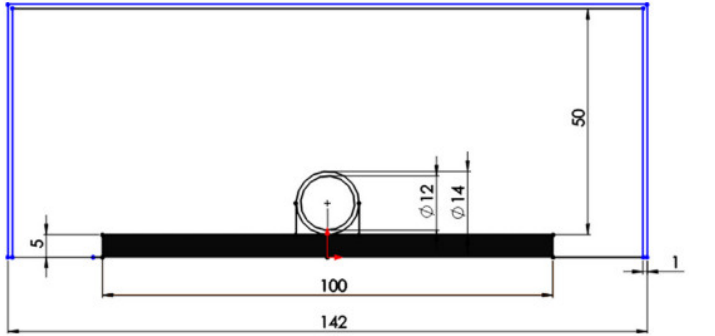
Figure 7. The cross-sectional view of the heat receiver tested in [83]. Dimensions in (mm). Reprinted with permission from Ref. [83]. 2019, Elsevier.